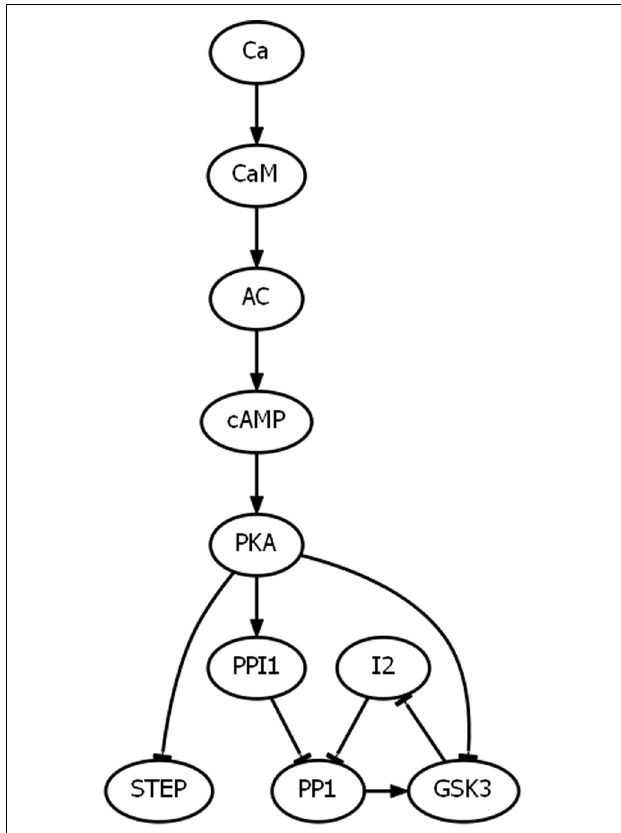
FIGURE 2 | The subset of interactions involved in PKA suppression of LTD. Experiments suggest (see subsection Experimental Data on Basic Mechanisms of LTP and LTD) that AC has a relatively high threshold and is only activated (via CaM) at the high levels of Ca that produce LTP. Once activated (via AC and cAMP), PKA suppresses LTD by inhibiting STEP, PP1, and GSK3. PKA inhibits STEP and GSK3 directly, but inhibits PP1 indirectly by activating PPI1 and by inhibiting GSK3, which would otherwise activate PP1 via disinhibition through